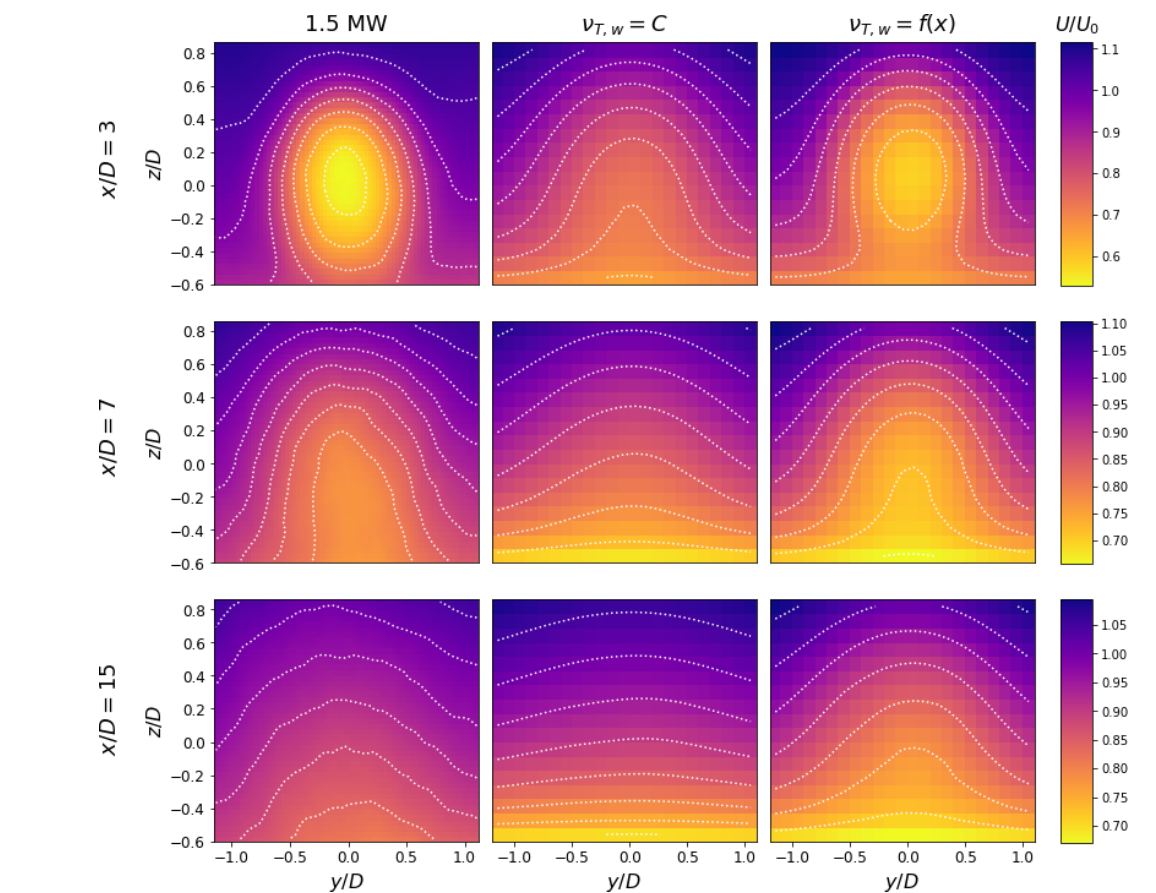
Figure 14. Contours of streamwise velocity in y – z planes for the aligned 1.5MW turbine. The proposed model replicates the near-wake velocity deficit as well as the far-wake profile, while the current formulation underpredicts at all downstream locations. The velocity gradient introduced by the mirror condition in the curled wake model is visible at x/D = 7 and x/D =